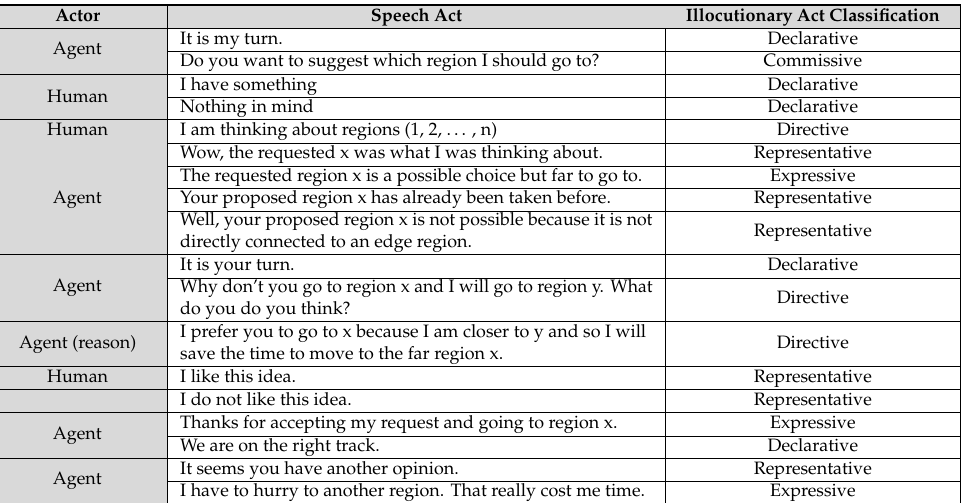
Table A1. Sample of human–agent